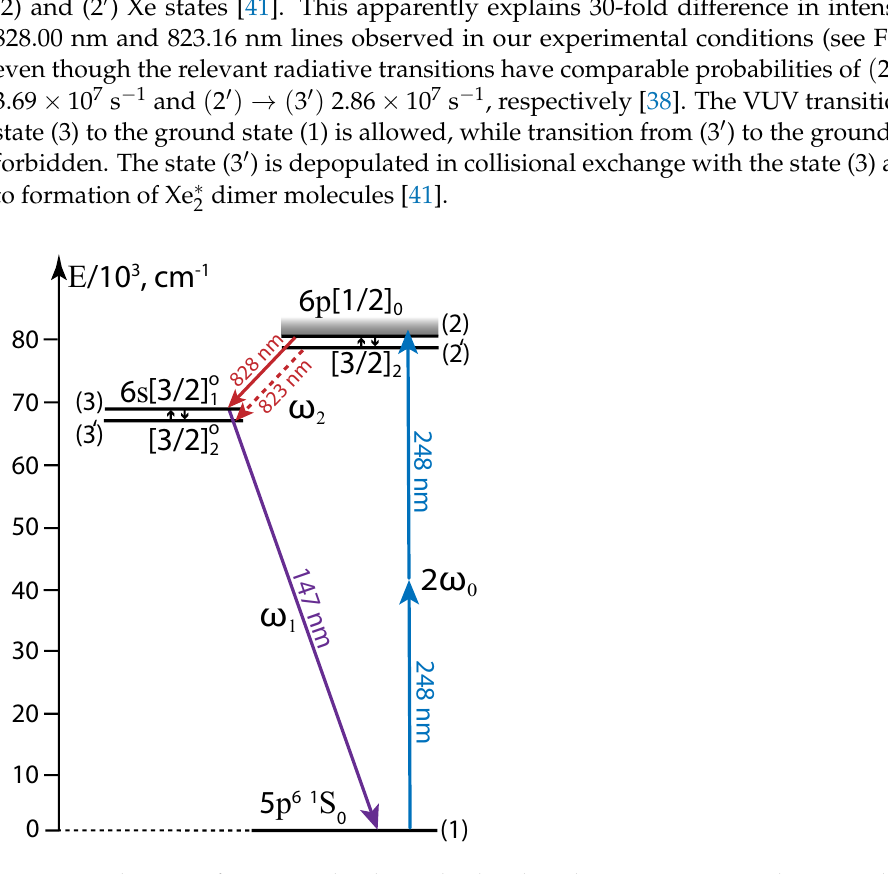
Figure 4. A diagram of atomic Xe levels involved in the coherent CE process, the energy levels are taken from [38]. A shadowed region shows a two-photon excitation band by SRRS-broadened KrF laser